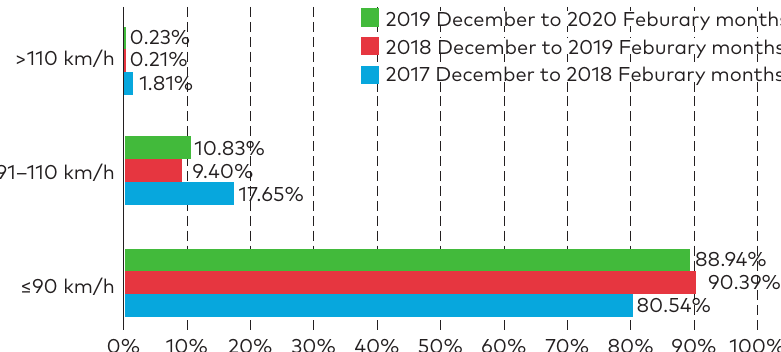
Figure 7. Comparison of speed data recorded by the average speed enforcement systems on main roads in the study